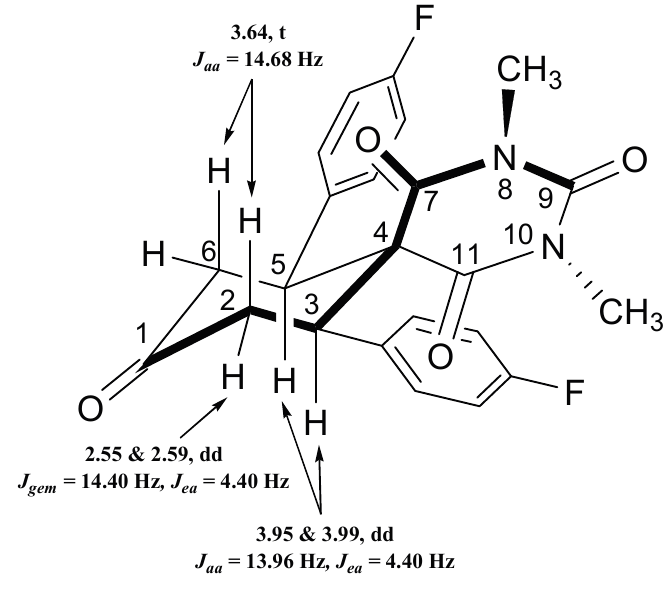
Figure 1. Structure representation for compound 3a